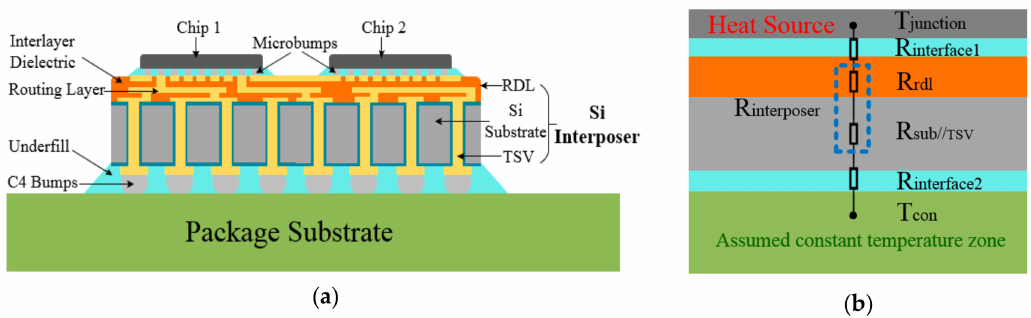
Figure 1. ( a ) Si interposer integration and ( b ) its heat conduction